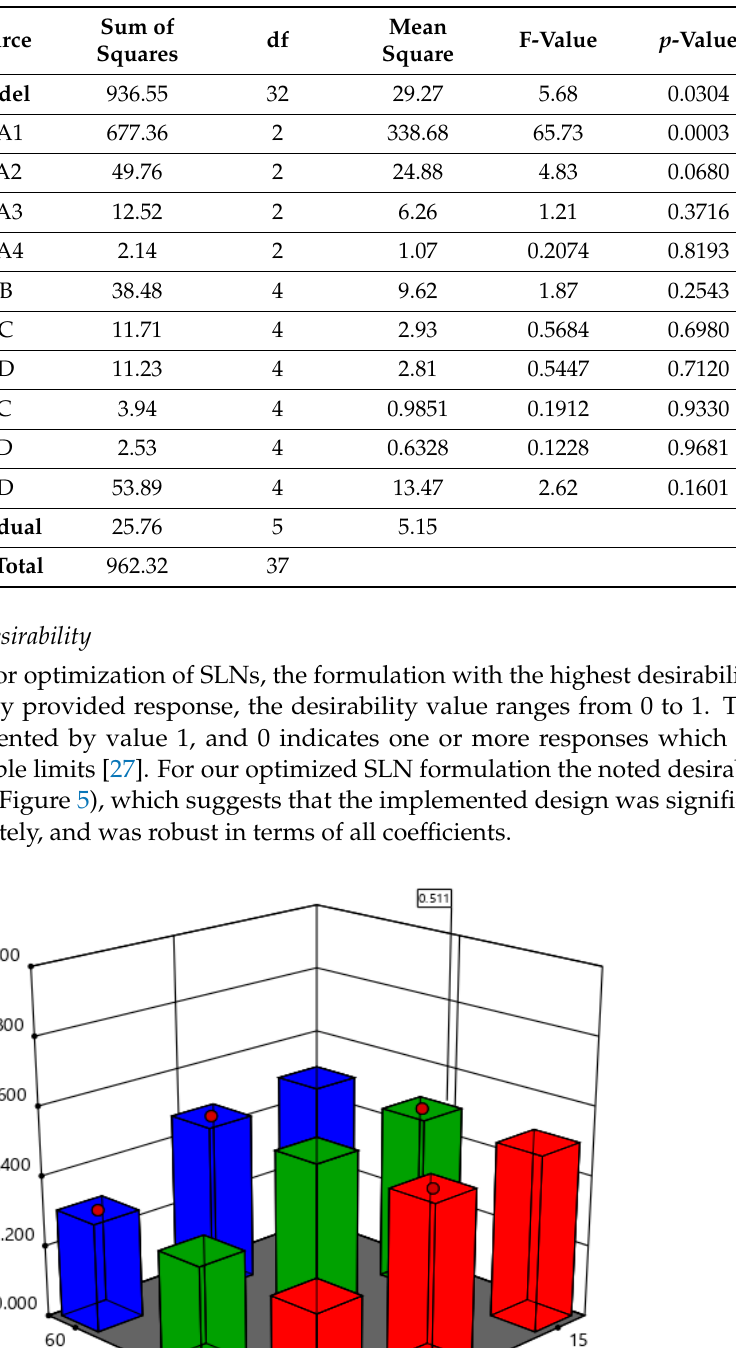
Table 3. Entrapment efficiency ANOVA response for 2FI model for the prepared Saxagliptin SLNs.